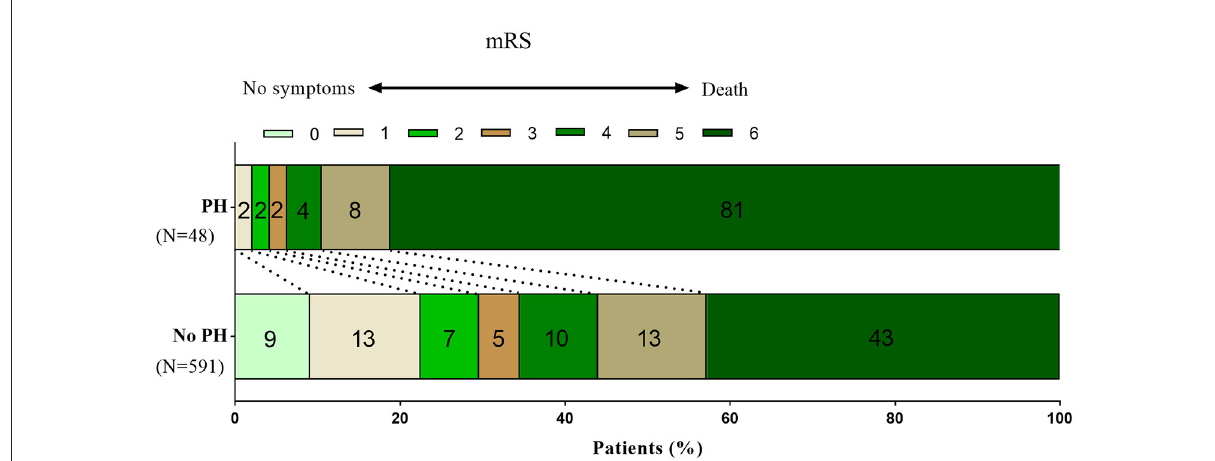
FIGURE1 Distribution of mRS scores at 90 days in patients with and without PH. Fewer patients with PH reached a favorable outcome (mRS0–3) at 90 days after the index stroke than patients without PH (6.3 vs. 34.5%, P < 0.001). Ninety-day mortality was higher in patients with PH than in patients without PH (81.3 vs. 42.8%, P < 0.001). mRS, modified Rankin scale; PH, parenchymal